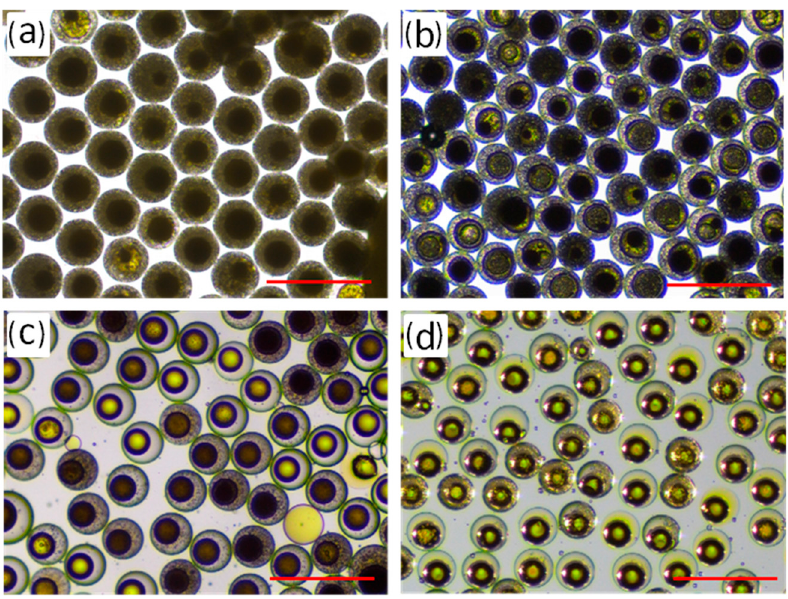
Figure 4. Optical microscopic images of the RF microsphere inside droplet at different holding times: ( a ) 10 min; ( b ) 15 min; ( c ) 20 min; ( d ) 30 min; the scale bar is 500 µm.